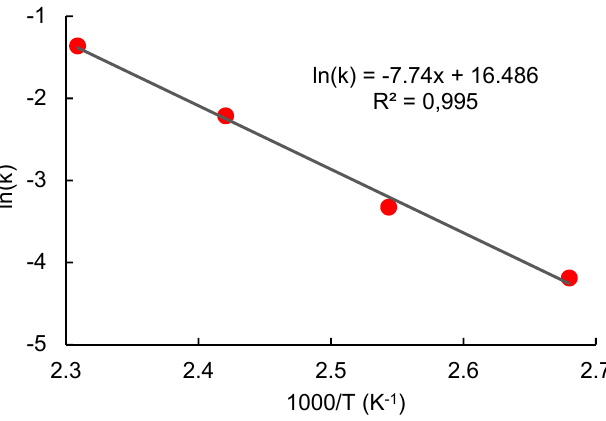
Figure 9. Arrhenius plot of the rate constant dependency on the reciprocal value of thermodynamic temperature.